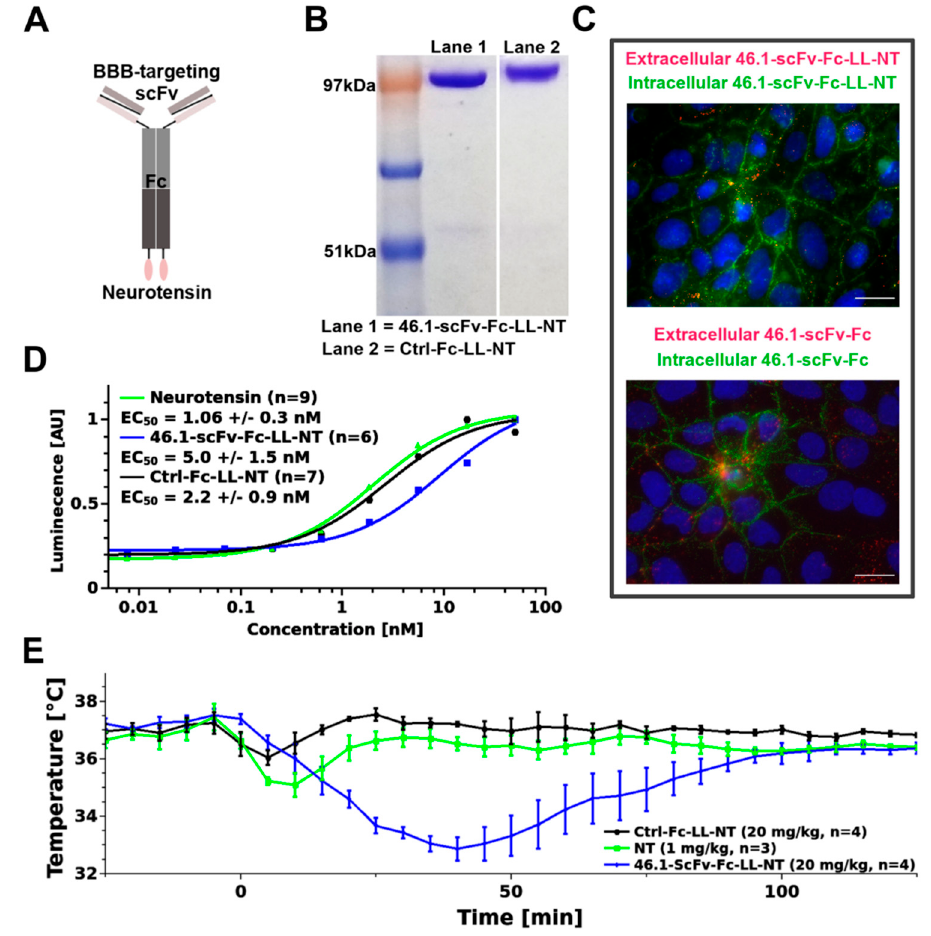
Figure 1. ScFv 46.1 transports neurotensin into the MnPO. ( A ) Cartoon of the antibody-NT construct. ( B ) Purified fusion constructs resolved with SDS-PAGE and Coomassie staining. ( C ) Conjugation of neurotensin to the parent antibody (lower image) has no influence on the binding- and internalization activity of 46.1-scFv-Fc-LL-NT (upper image) in iPSC-BMEC-like cells, as evident from both antibodies having a characteristic punctate appearance on the plasma membrane (pseudocolored in red) and localization to the internal cell–cell contacts (pseudocolored in green). Scale bar, 20 µm. ( D ) NT alone or antibody-NT-fusions (control and 46.1 antibody) were added in serial dilutions to NTSR1 (G-protein coupled receptor (GPCR)) expressing CHO-cells. The activation of NTSR1 was measured as a chemiluminescent light, produced by active β -galactosidase, which formed upon the recruitment of β -arrestin to the NTSR1 construct. The inset provides the fitted EC 50 values (mean ± s.e.m.). The curves represent one biological replicate and n is listed in the inset. One-way ANOVA was used